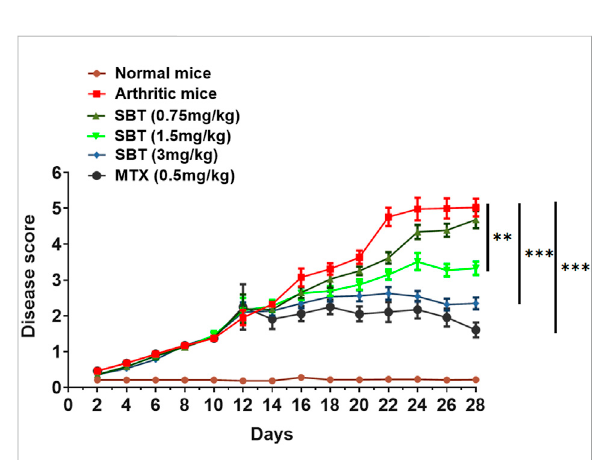
FIGURE 2 SBT decreases disease severity in mice. Disease score